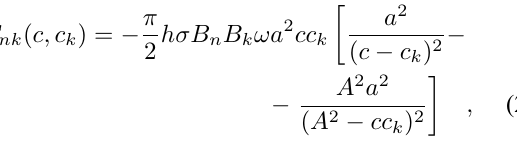
T nk ( α ) and | c − c k | = 2 a for T nk ( c, c k ) . Fig. 3 shows the behavior of the braking factors poles and − T nk ( c, c − 2 a ) /hσB n B k ω for parallel poles as functions of the distance c for fixed A/a = 10 . We can see that all the torques attain a maximum for certain values of the distance c near the limit value c = A − a . The maximums of the mutual torques are near the max- imum of T nn given in Eq. 17. For the conditions shown in Fig. 3 we obtain that the maximum of T nk ( α min ) occurs at c ≃ 0 . 874 A while the maximum of T nk ( c, c − 2 a ) occurs at c ≃ 0 . 881 A . Fig. 4 shows the total torque per pole T = ( T 11 + T 22 + 2 T 12 ) / 2 for two poles touching each other as a function of the parameter c/A . We assume B n = B = − B k for the plot of T ( α min ) = [ T 11 ( c ) + T 22 ( c ) + 2 T 12 ( α min )] / 2 , which has a peak at ˜ c 1 ≃ 0 . 864 A and B n = B = B k for the plot of T ( c, c